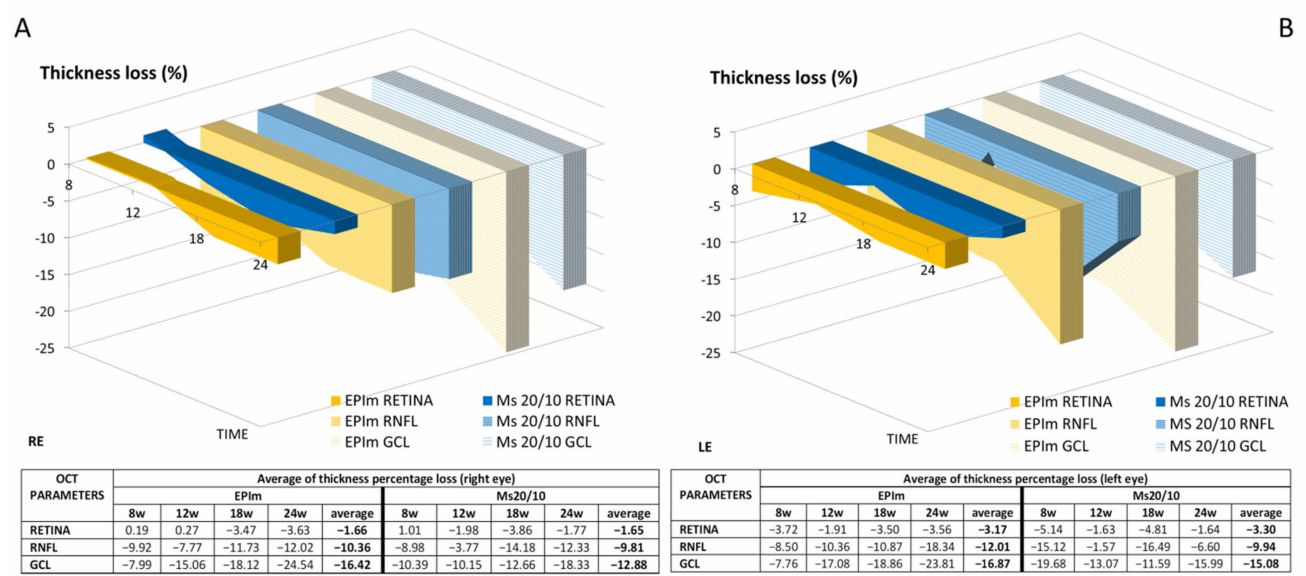
Figure 6. Percentage of thickness loss measured by OCT in both OHT models over 6 months’ follow-up. ( A ): Right eye (RE) analysis. ( B ): Left eye (LE) analysis. Abbreviations: EPIm: episcleral sclerosis model; Ms20/10: microsphere 20/10 model;